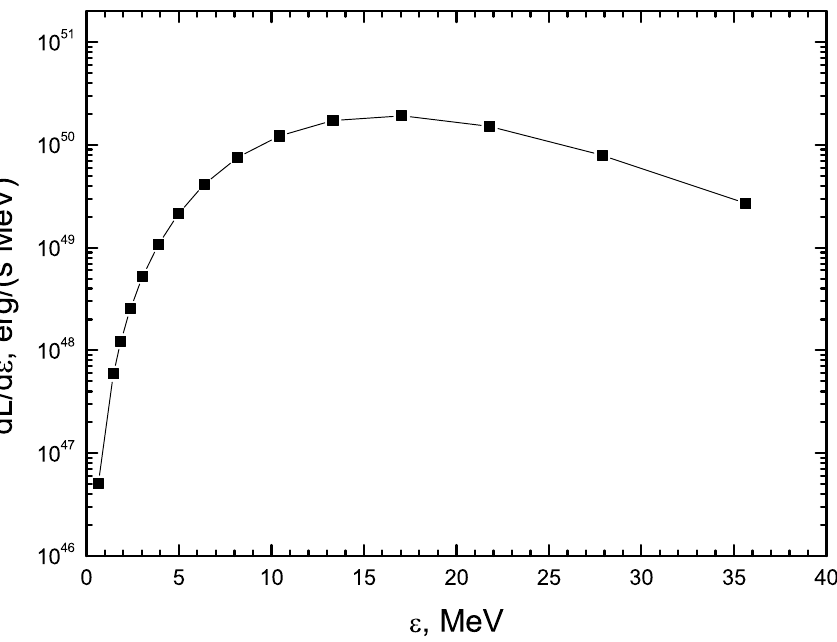
Figure 4. Spectral luminosity dL / d (cid:101) for outgoing neutrino above the neutrinosphere r = 5.5 × 10 6 cm at the time t = 12